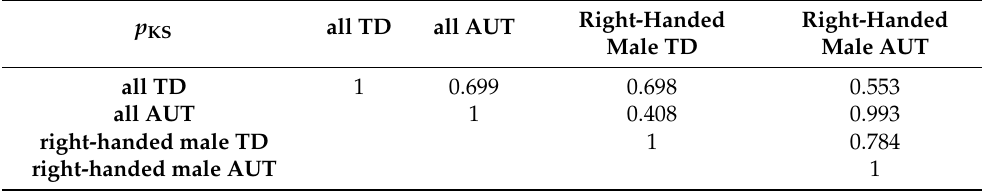
Table 1. p -values from the Kolmogorov-Smirnov tests ( p KS ) used to compare group age. TD: typically developing; AUT: autistic disorder. Right-Handed p KS all TD all AUT Right-Handed Male TD Male AUT all TD 1 0.699 0.698 0.553 all AUT 1 0.408 0.993 right-handed male TD 1 0.784 right-handed male